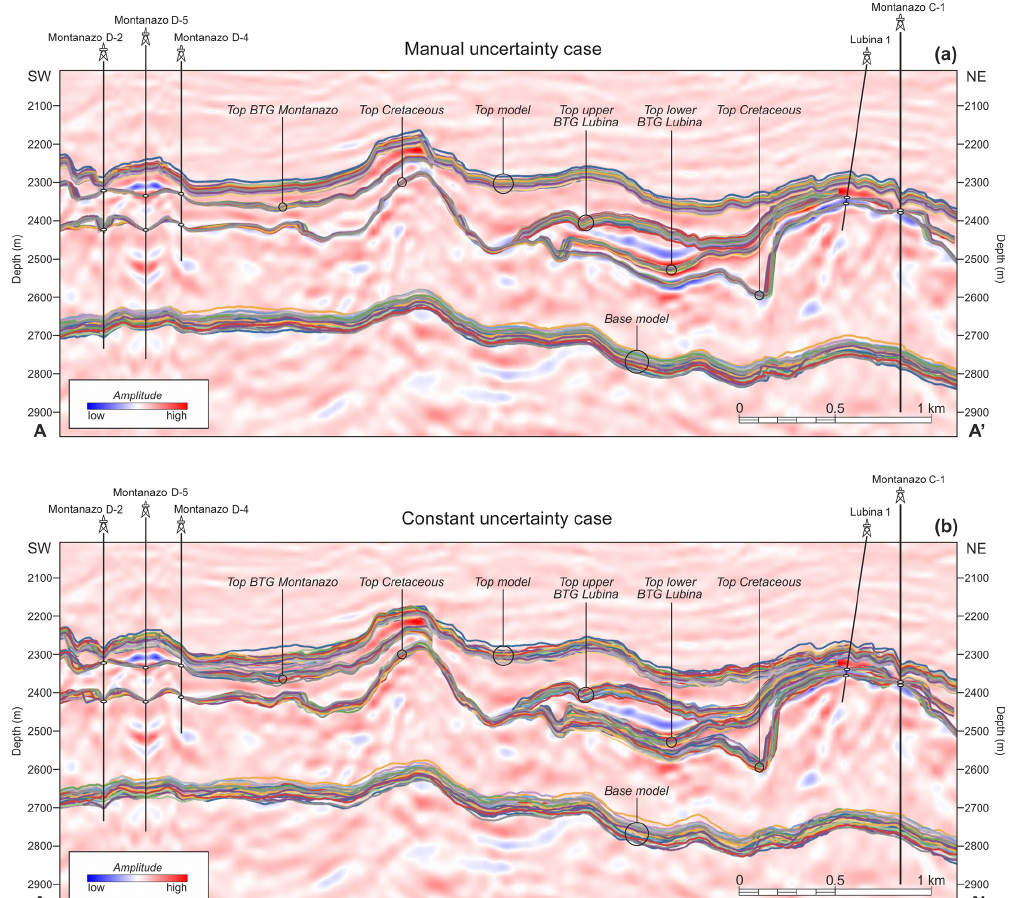
Figure 16. Multiple realizations of the horizons modeled by capturing the uncertainty using the manual and the constant uncertainty cases. Only 50 of the 200 realizations are shown in each case. Note that the uncertainty is nonexistent in the well positions for those horizons with well picks and that the horizons showing the maximum spread are those without well pick data available. It can also be appreciated that the spread of uncertainty is visually higher in the constant than in the manual uncertainty cases and that in both cases increases with the depth of the